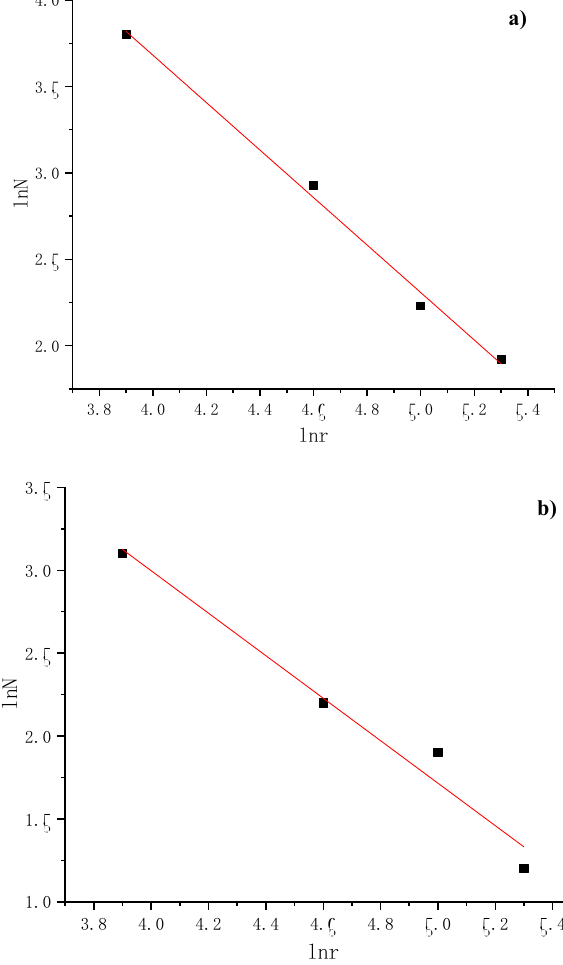
fi tting of Type III ( a ) and Type II ( b ) recycled sand.